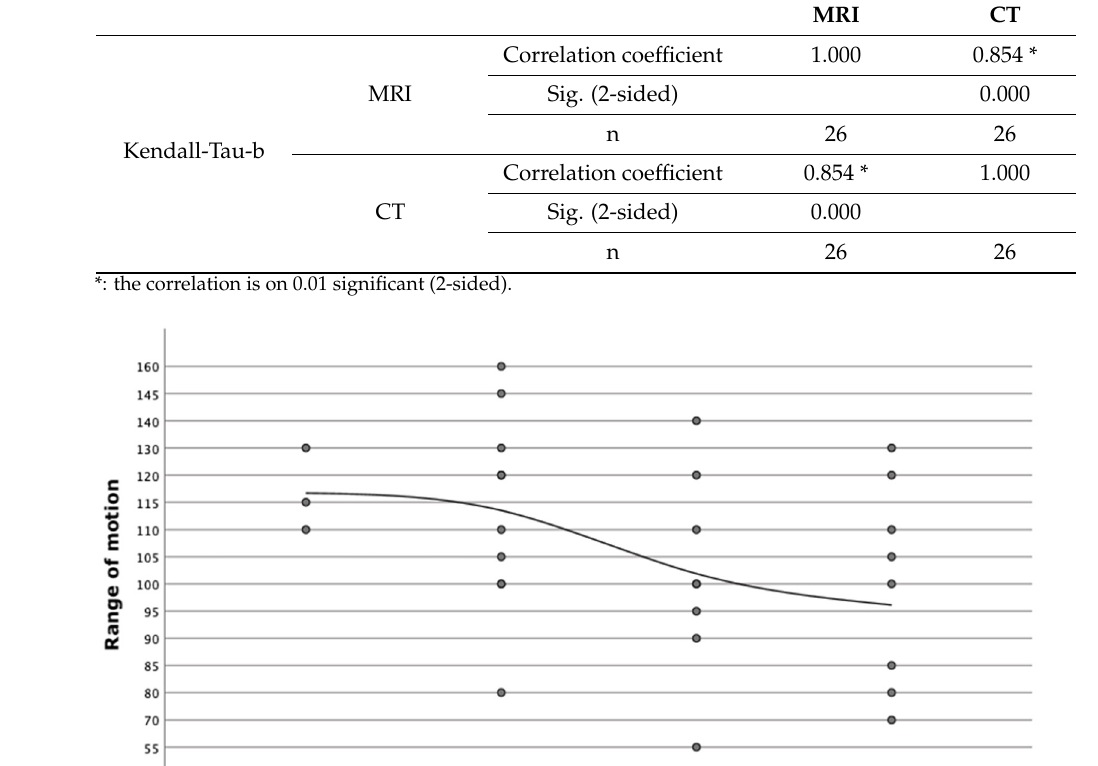
Table 4. Correlation between cartilage lesion stage in MRI and CT.